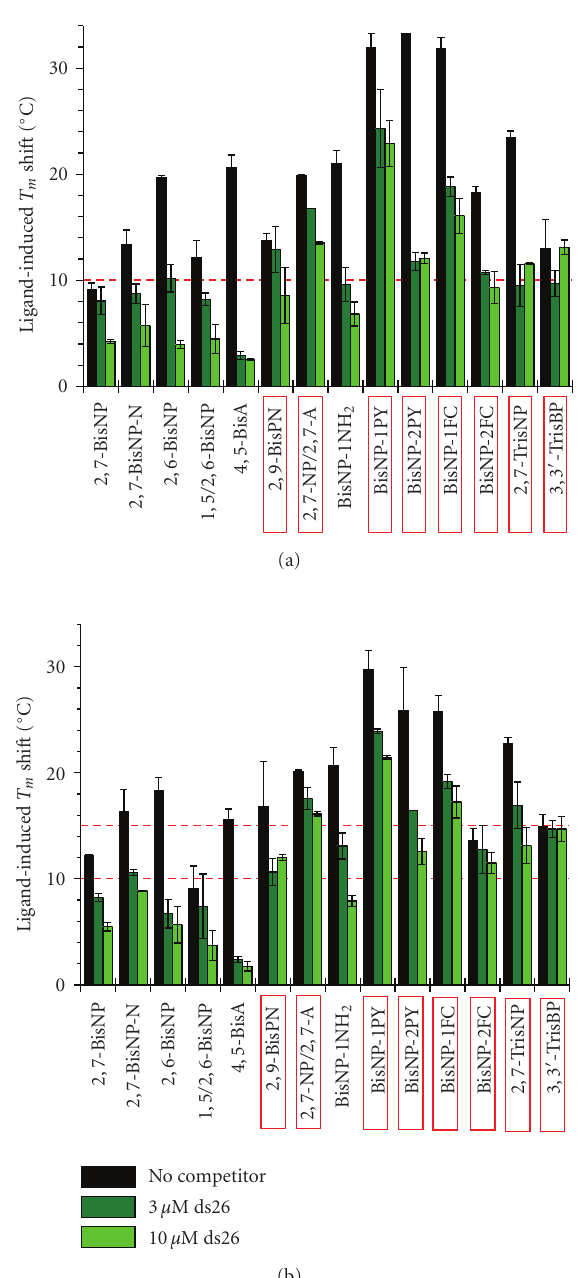
Figure 7: Stabilisation of F21T oligonucleotide ( Δ T 1 / 2 , ◦ C) induced by CBI and CTI macrocycles (1 μ M) in (a) Na + - and (b) K + -rich conditions, for experiments carried out in the absence (black bars) or in the presence of 3 (dark green bars) or 10 μ M (light green bars) of the duplex competitor (ds26).